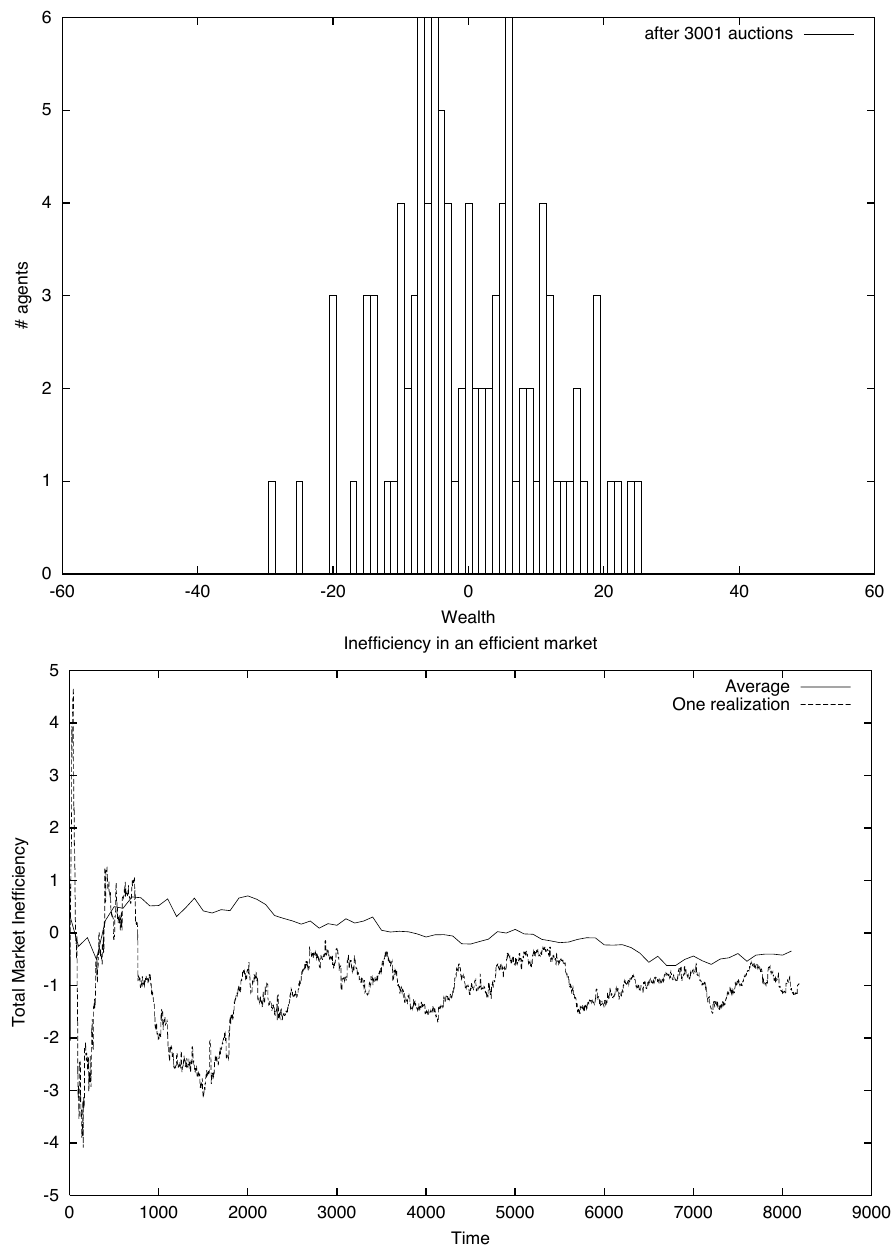
Figure 1. Histogram of ETR for 100 (90, 10) traders ( top ) and Graph of I ij ( t ,0 ) for a fixed random subgroup of 50 noise traders in a homogeneous market ( bottom